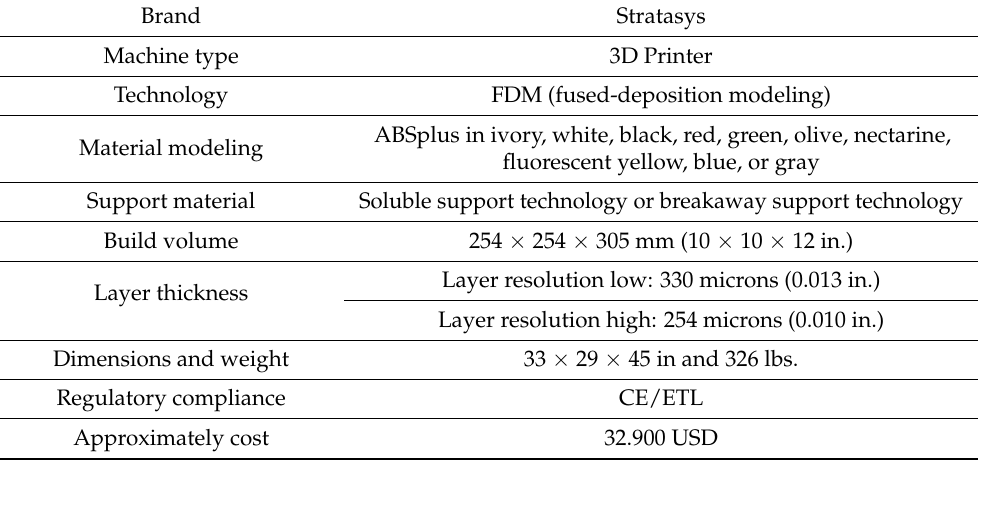
Table 1. Dimensions of the SST 1200es printer.